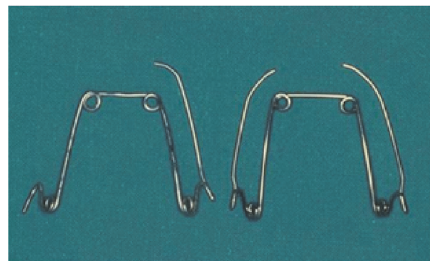
Figure 4: Asymmetric Quad Helix (left) and traditional Quad Helix (right).